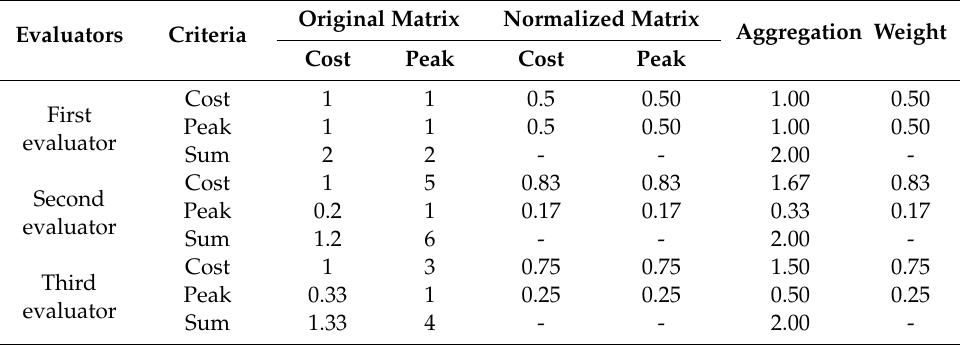
Table 4. Analytic hierarchy process (AHP) processing matrix for calculating the criteria’s